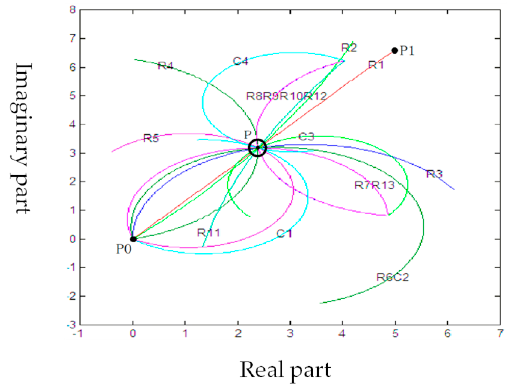
Figure 3. The circle model of Leapfrog circuit.